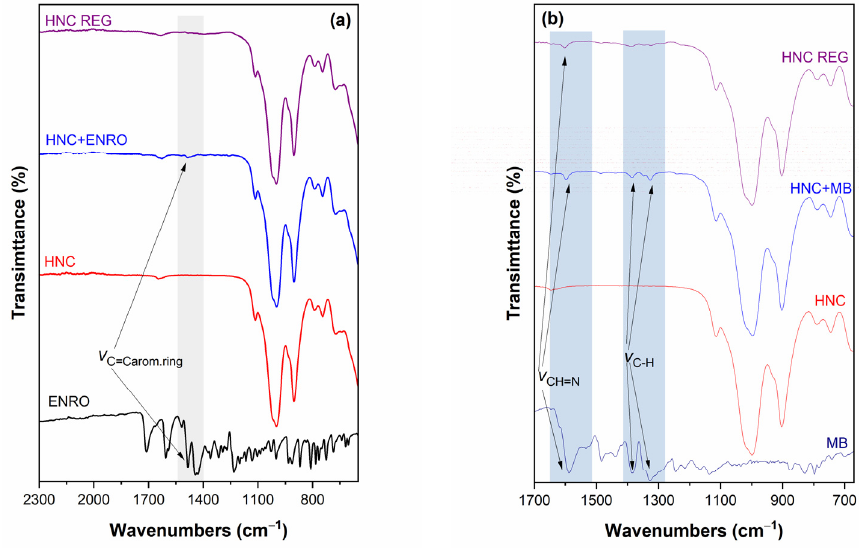
Figure 2. The ATR/FTIR spectra of ( a ) pristine HNC, ENRO, HNC after adsorption of ENRO and HNC after CAP regeneration, and ( b ) pristine HNC, MB, HNC after adsorption of MB and HNC after CAP regeneration in the selected spectral window. Grey and blue highlighted areas point out the differences in representative peaks for raw and regenerated HNC for ENRO and MB, respectively.